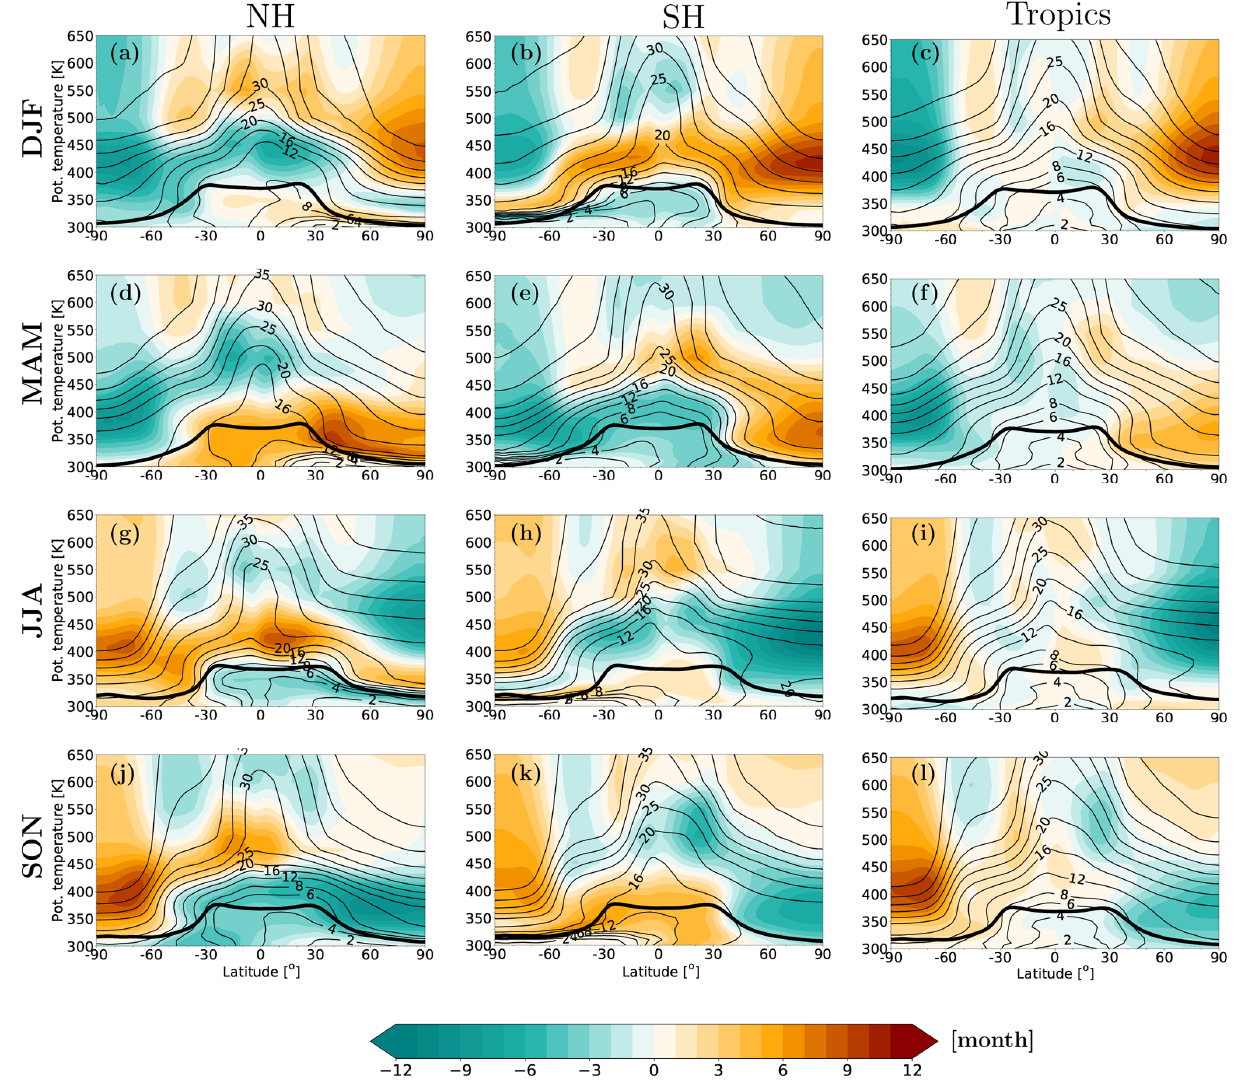
Figure 6. Climatology of the mean AoA (1999–2017, black contours) and the AoA anomaly with respect to this climatology (color shading) from the NH extratropics, SH extratropics, and tropics for each season. The black line shows the WMO